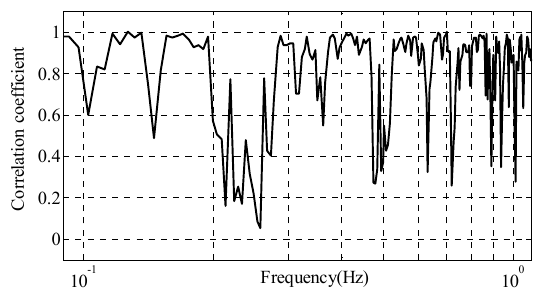
Figure 10. The correlation coefficient of the interference field in OPM-I and OPM-II.